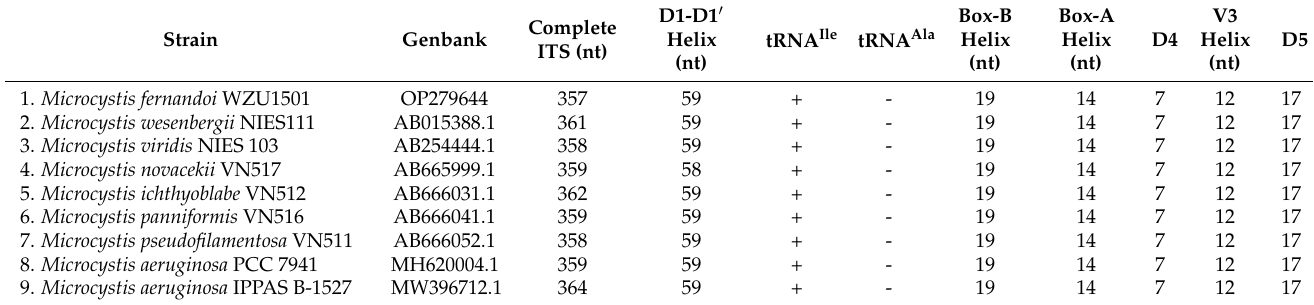
Table 2. Analyses on ITS of 16S–23S region for Microcystis fernandoi WZU 1501 and other related strains.